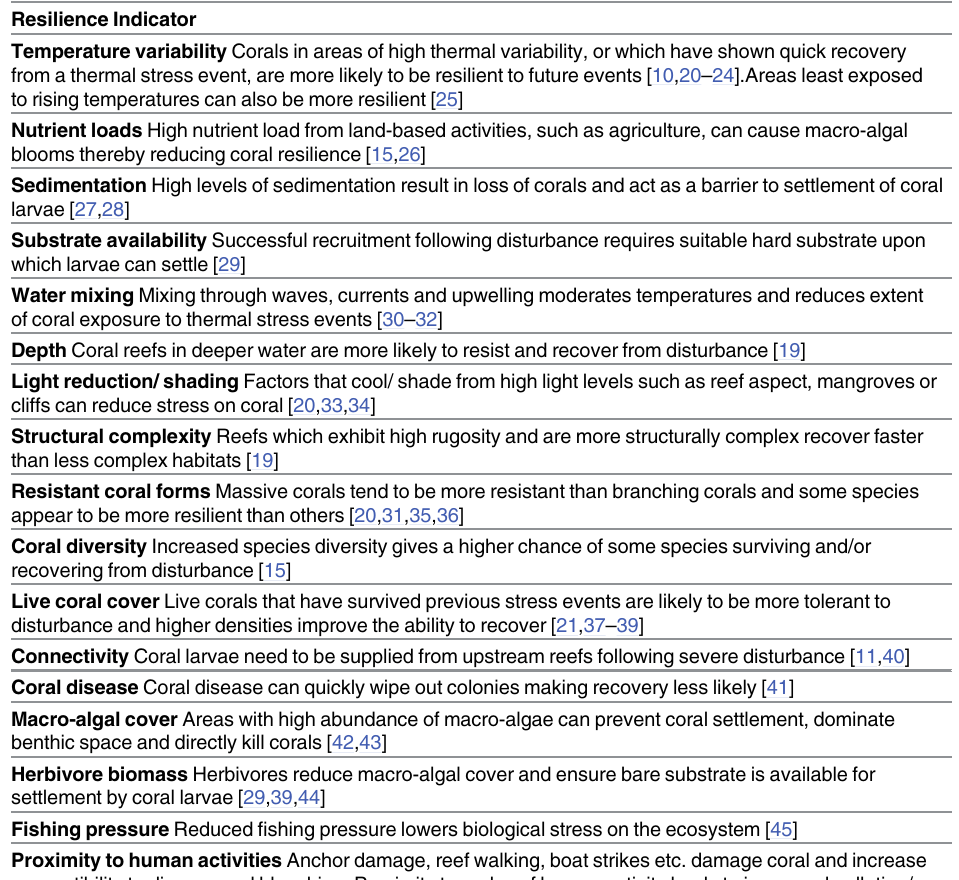
Table 1. Synthesis of current literature identifying key features which may determine coral reef resil- ience [15 – 19]. Resilience